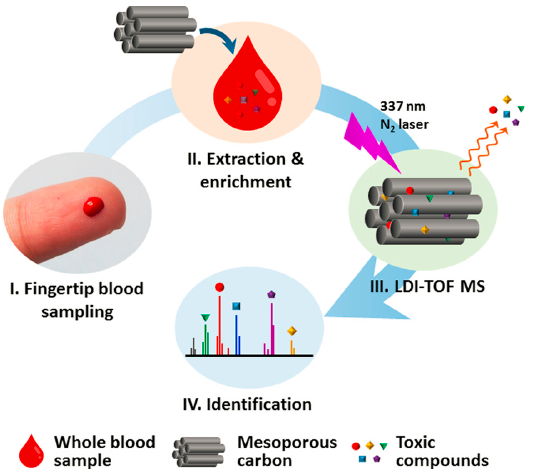
Figure 4. Scheme showing the procedures for the screening of toxic chemicals in a single drop of human whole blood. Reproduced with permission of [116].